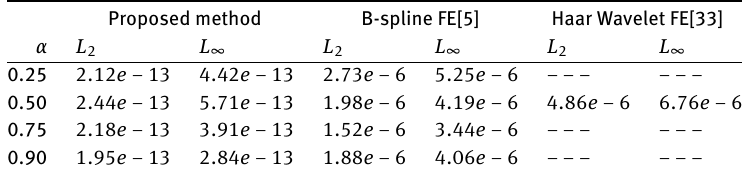
Table 3: A comparison of the proposed method and FE [5] to solve example 2.